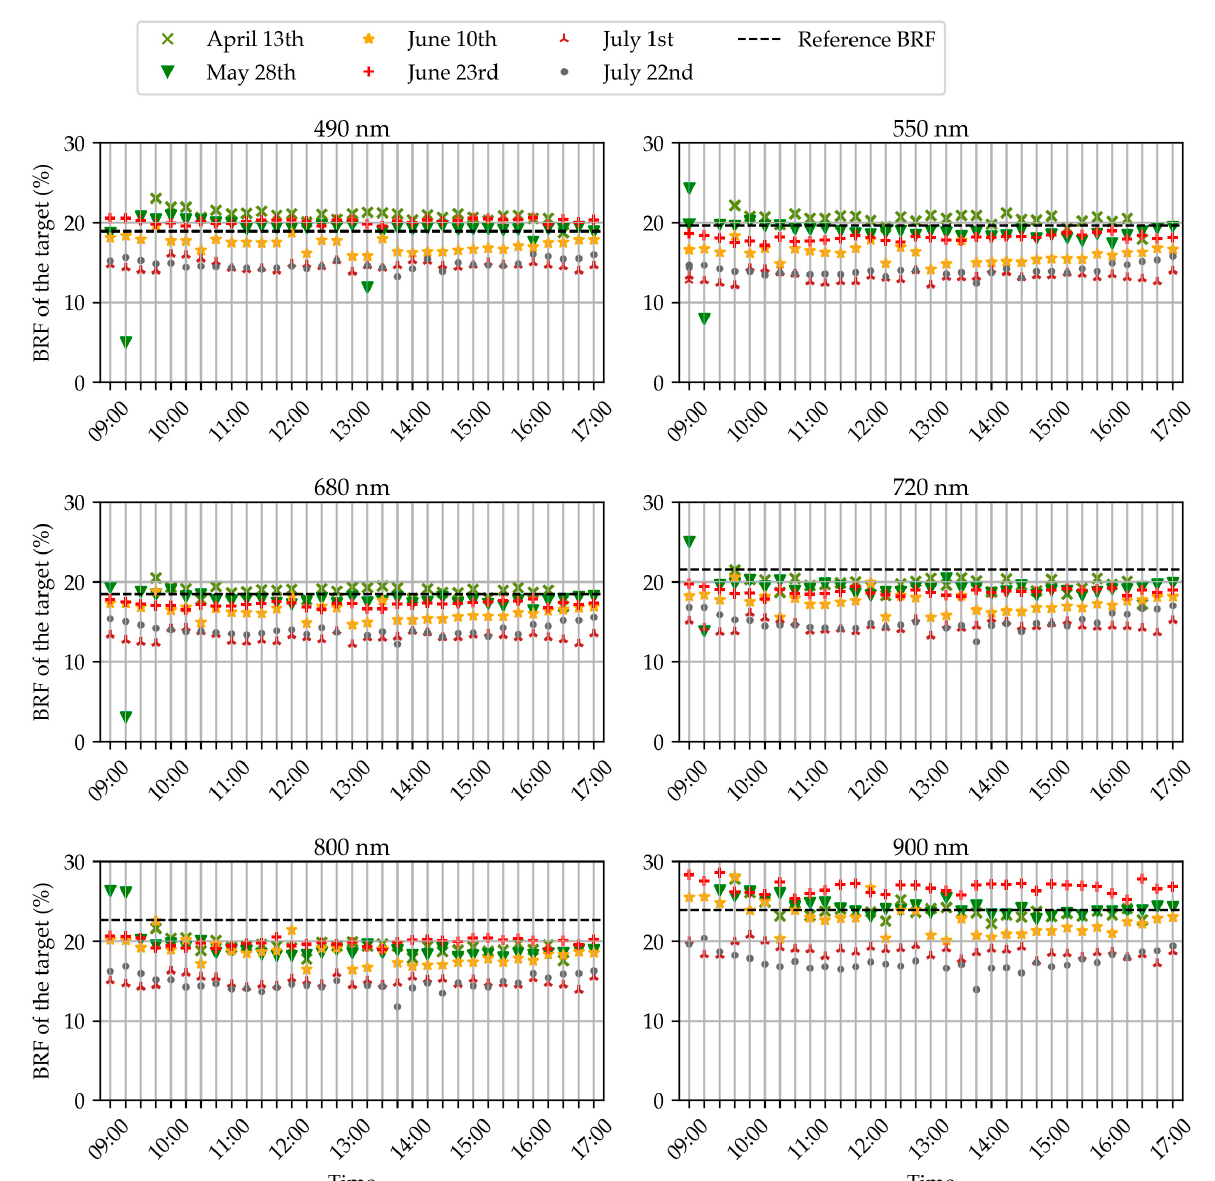
Figure 5. Evolution throughout the day of the average bi-directional reflectance factor (BRF) measured on the dark gray target. Each subplot is dedicated to a camera of the multispectral array, designated by the central wavelength of its optical filter. The evolution of the measured BRF is represented for six different acquisition dates, indicated by a color and symbol code on each subplot. The dotted line corresponds to the theoretical BRF of the target that was provided by the manufacturer.